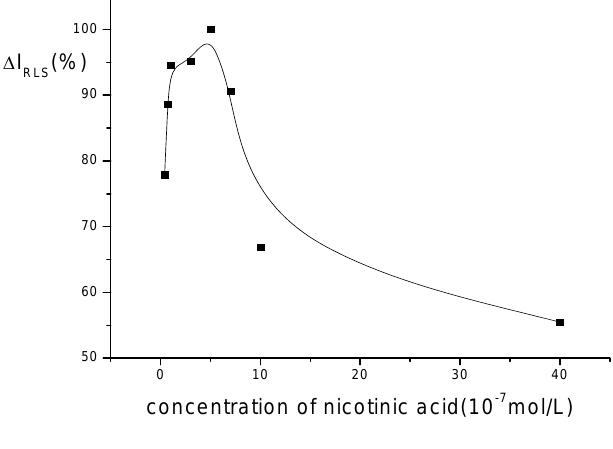
Figure 4 . Effect of nicotinic acid concentration on RLS intensity of Eu 3+ -nicotinic